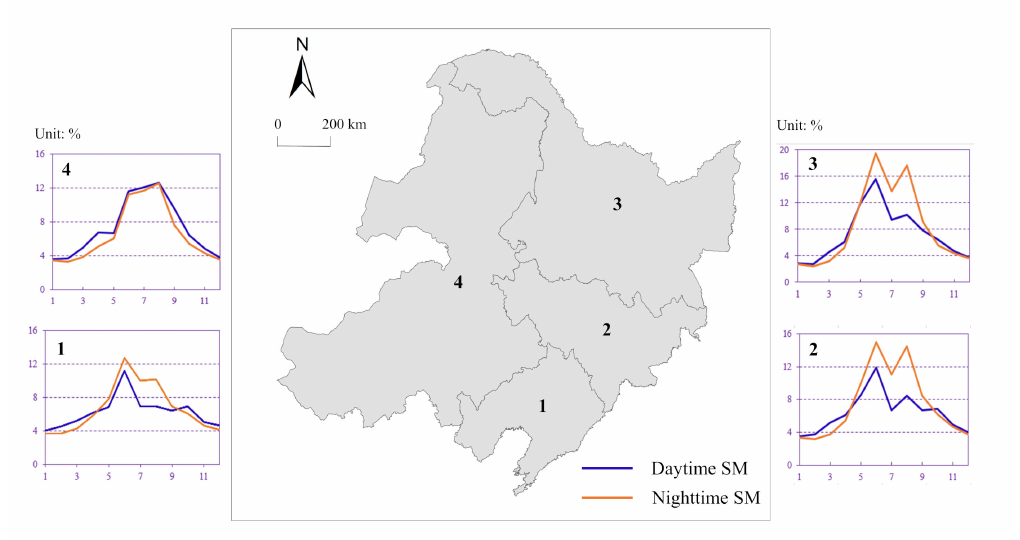
Figure 4. Spatial variations in the RMSE for each meteorological station in the study area in the study time series for ( a ) daytime and ( b ) nighttime.